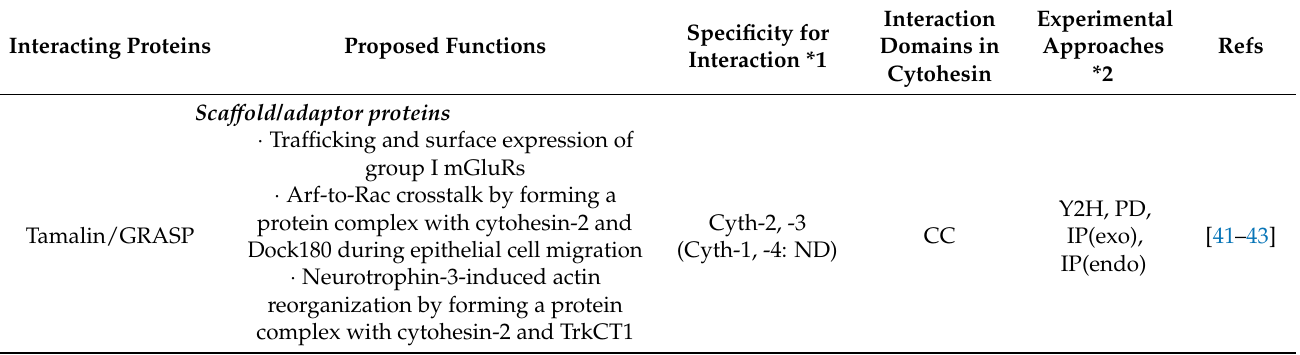
Table 1. Cytohesin-interacting